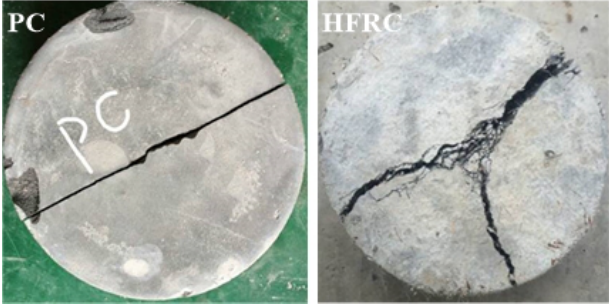
Figure 6. Failure patterns of PC and HFRC